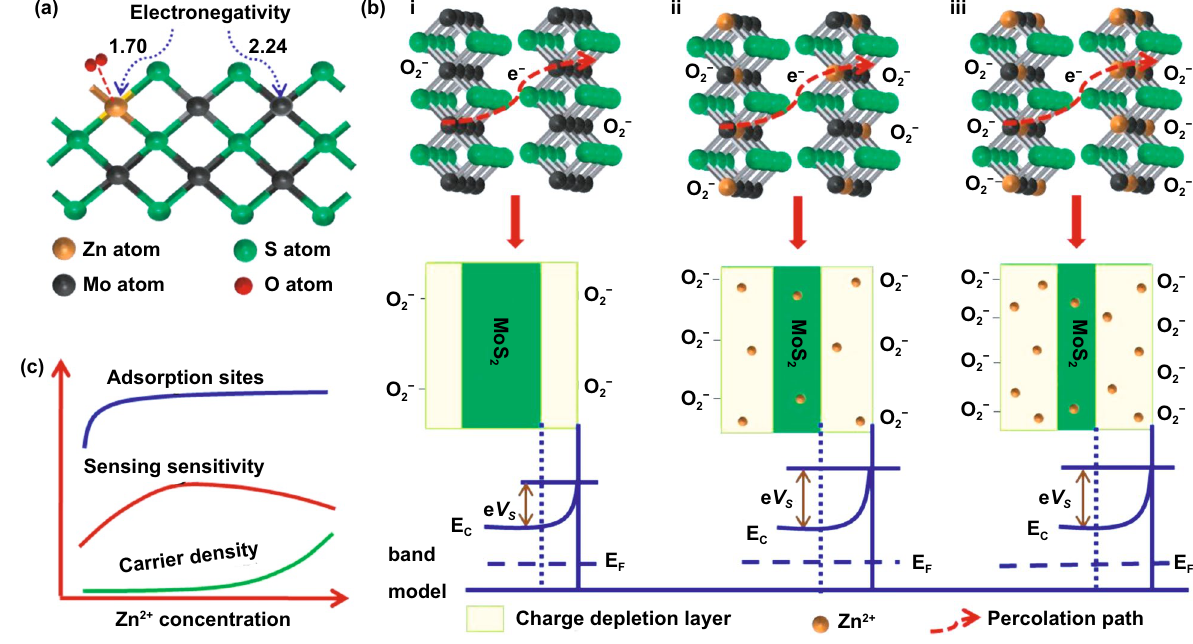
Fig. 15 a Surface adsorption illustration of Zn: MoS 2 UNs, b structural and band models showing the role of doping Zn 2+ , i: pure MoS 2 , ii: MoS 2 with intermediate Zn 2+ concentration, iii: MoS 2 with high Zn 2+ concentration, and c possible effects of Zn 2+ concentration on absorption capacity, carrier density and sensing sensitivity. Reprinted from Ref. [221] with permission. Copyright 2018,